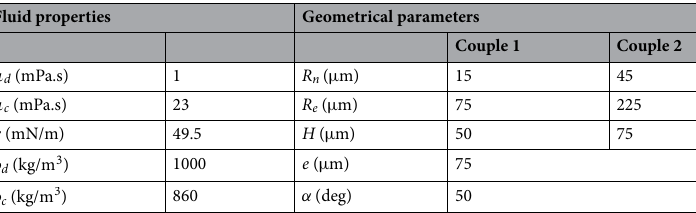
Table 1. Fluid properties and geometrical parameters used in this work with water and oil for the dispersed and the continuous phases, respectively. “Couple” refers to a specific combination of a nozzle and an extraction